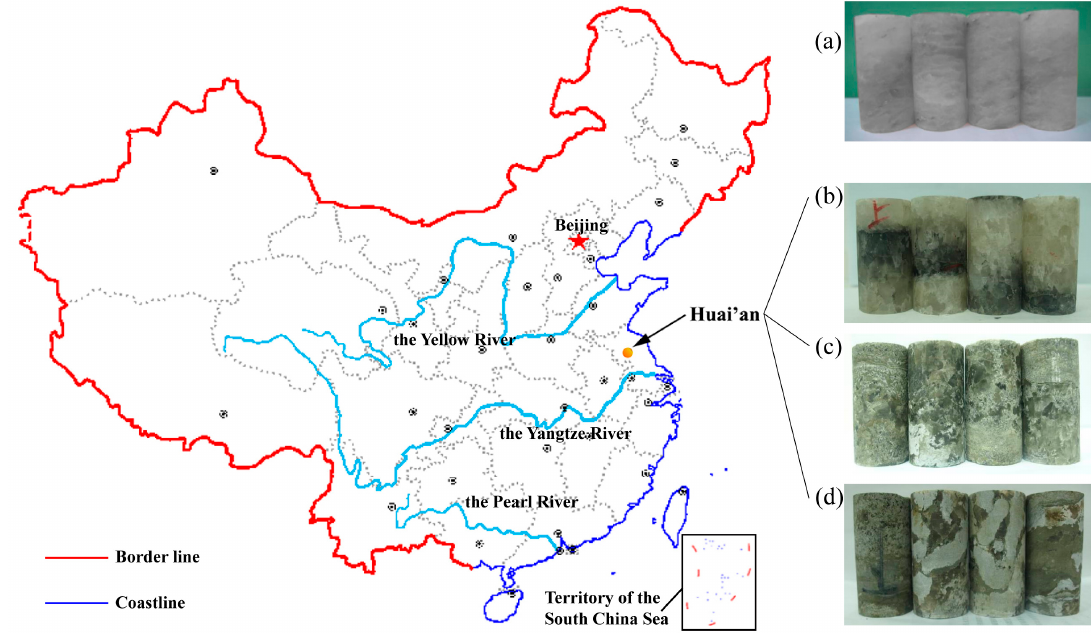
Figure 1. Salt rock specimens with different impurity contents. ( a ) Pure salt rock; ( b ) Salt rock with low impurity content; ( c ) Salt rock with medium impurity content; ( d ) Salt bearing sedimentary rock samples.